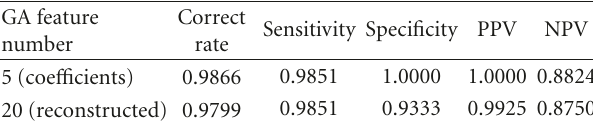
Table 3: Performance of selected GA features. This table shows the performance for lung cancer dataset. PPV stands for positive predictive value; NPV stands for negative predictive value.